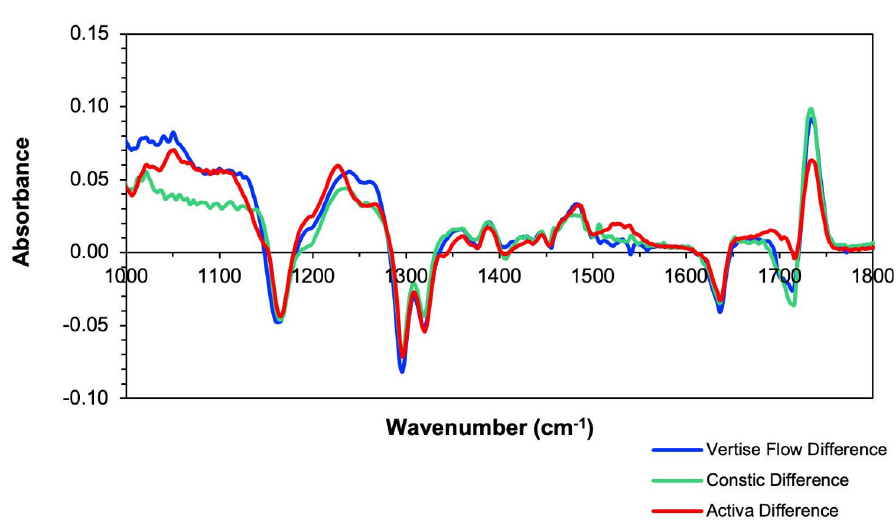
Fig 3. FTIR difference spectra (initial–final spectrum). Graph shows peak shifts owing to the polymerisation reaction. Absorbance changes are seen in the 1160 cm -1 [v(C-O-C)], 1300–1320 [v(C-O)] which shift to lower wavenumbers, at 1230 and 1268 cm -1 , and absorbance change of [v(C = C)] at 1640 cm -1 . Spectra also show noise around the 1500–1800 cm -1 region, with a smooth region between 1100–1500 cm -1 .